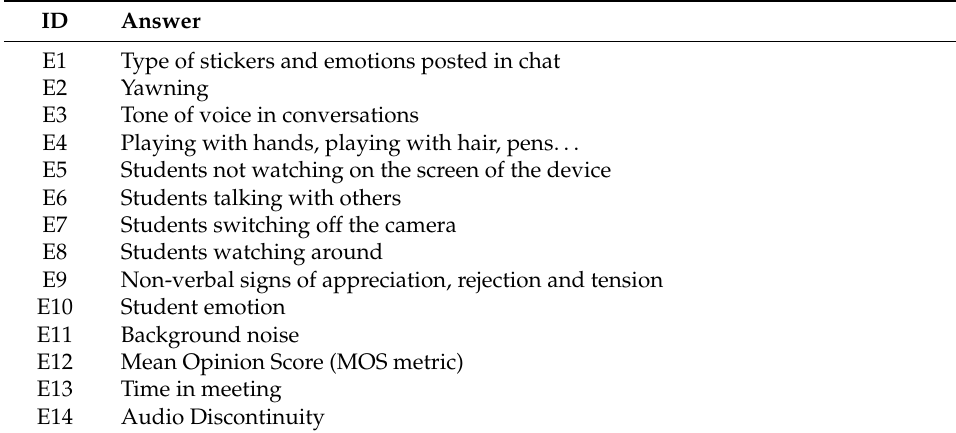
Table 2. Answers from the emotional category.